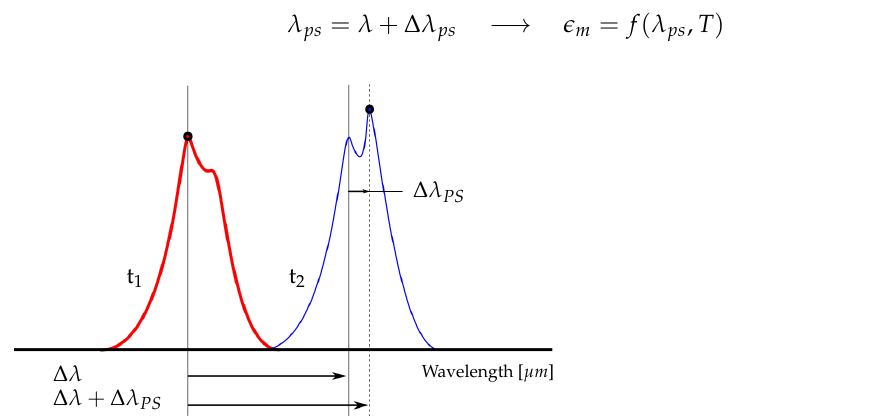
Figure 1. Illustration of peak splitting and switching between two consecutively measured spectra